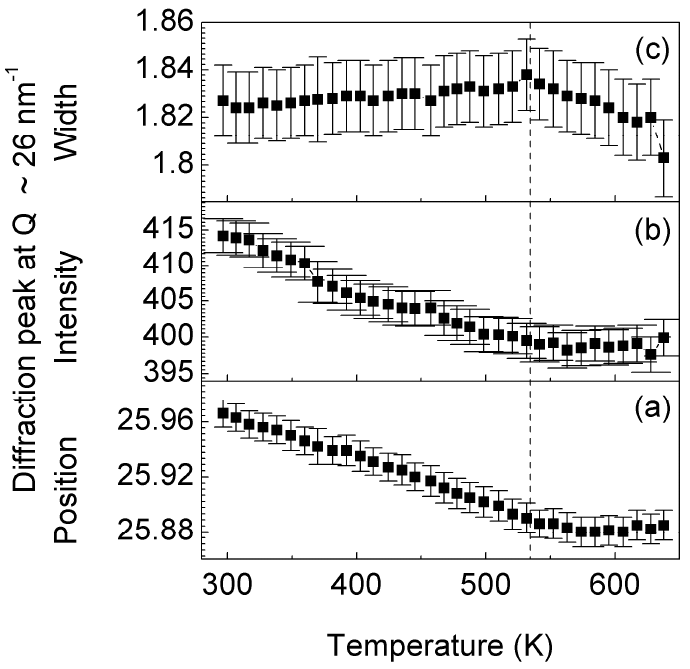
Figure 4. Temperature dependence of the ( a ) position; ( b ) intensity; and ( c ) width of the main amorphous maximum at about Q = 26 nm − 1 in Figure 2.